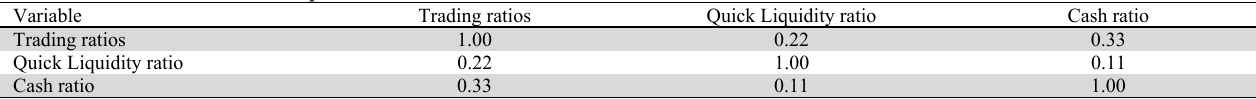
The correlation matrix for independent